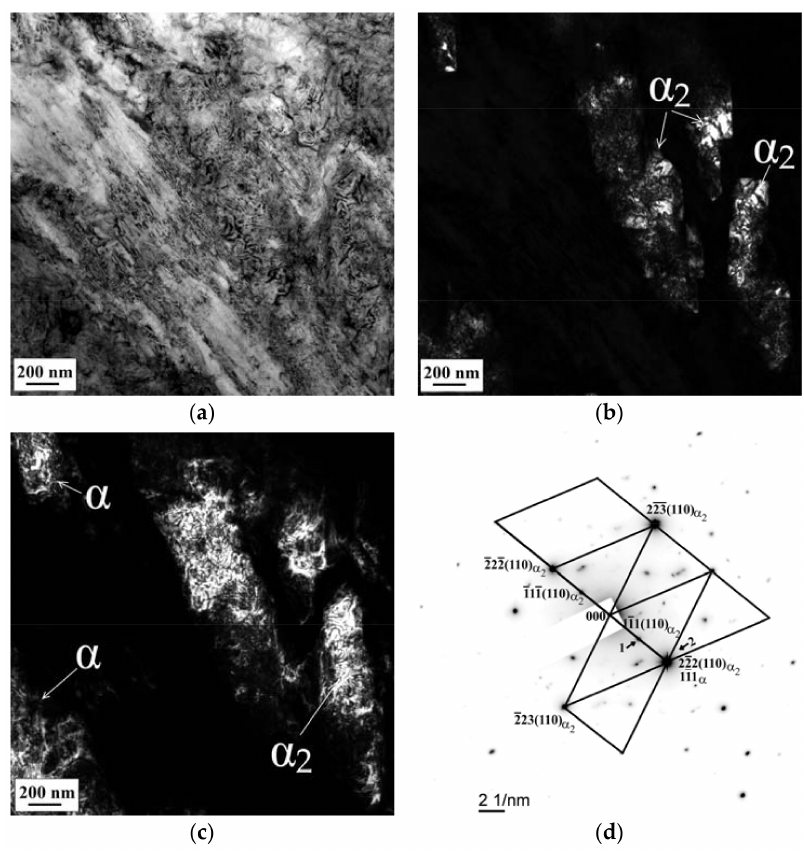
Figure 6. TEM bright- ( a ) and dark-field images ( b , c ) and associated SAED pattern ( d ) of the microstructure of EBM titanium Ti-6Al-4V parts after hydrogenation to 0.29 wt. %; b—the dark-field image obtained with 111 Ti 3 Al superstructure reflection (marked by an arrow 1); c—the dark-field image obtained with 222 Ti 3 Al and 111 α -Ti reflection (marked by an arrow